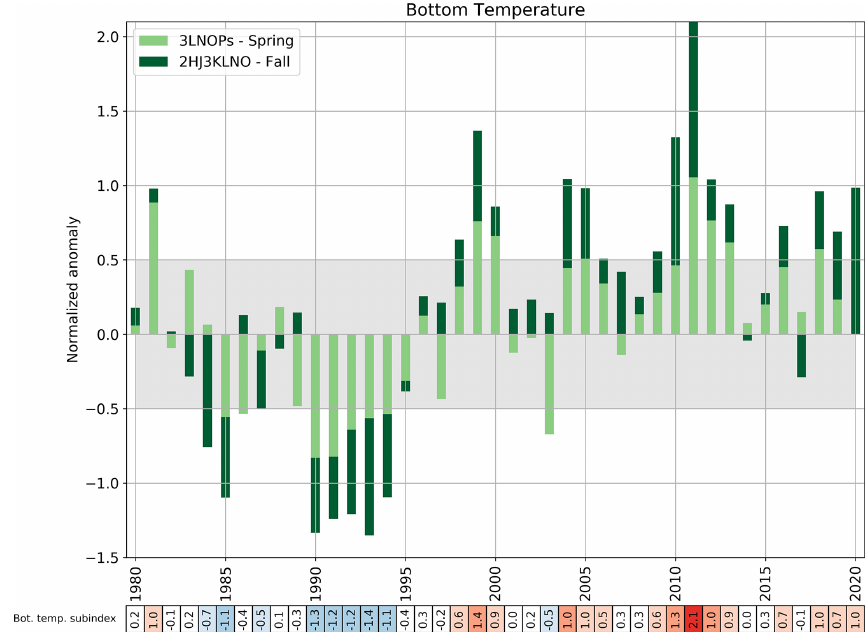
Figure A7. Same as Fig. 11 but using a climatology referenced to the 1981–2010 period.